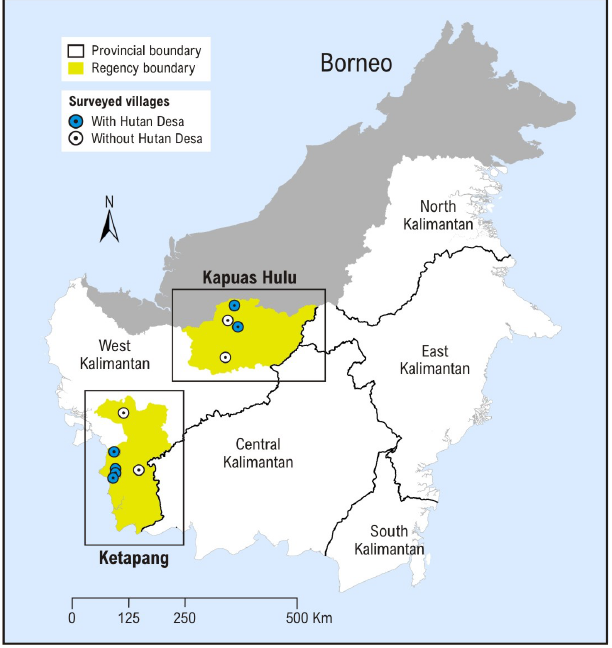
Fig. 2 . Map of household questionnaire sites in West